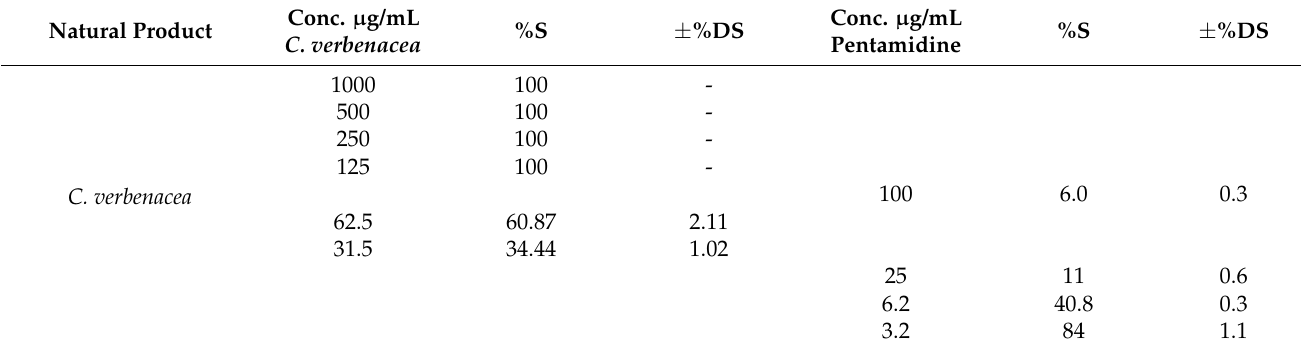
Table 3. Survival of the promastigote L. brasiliensis treated with C. verbenaceae essential oil. Natural Product